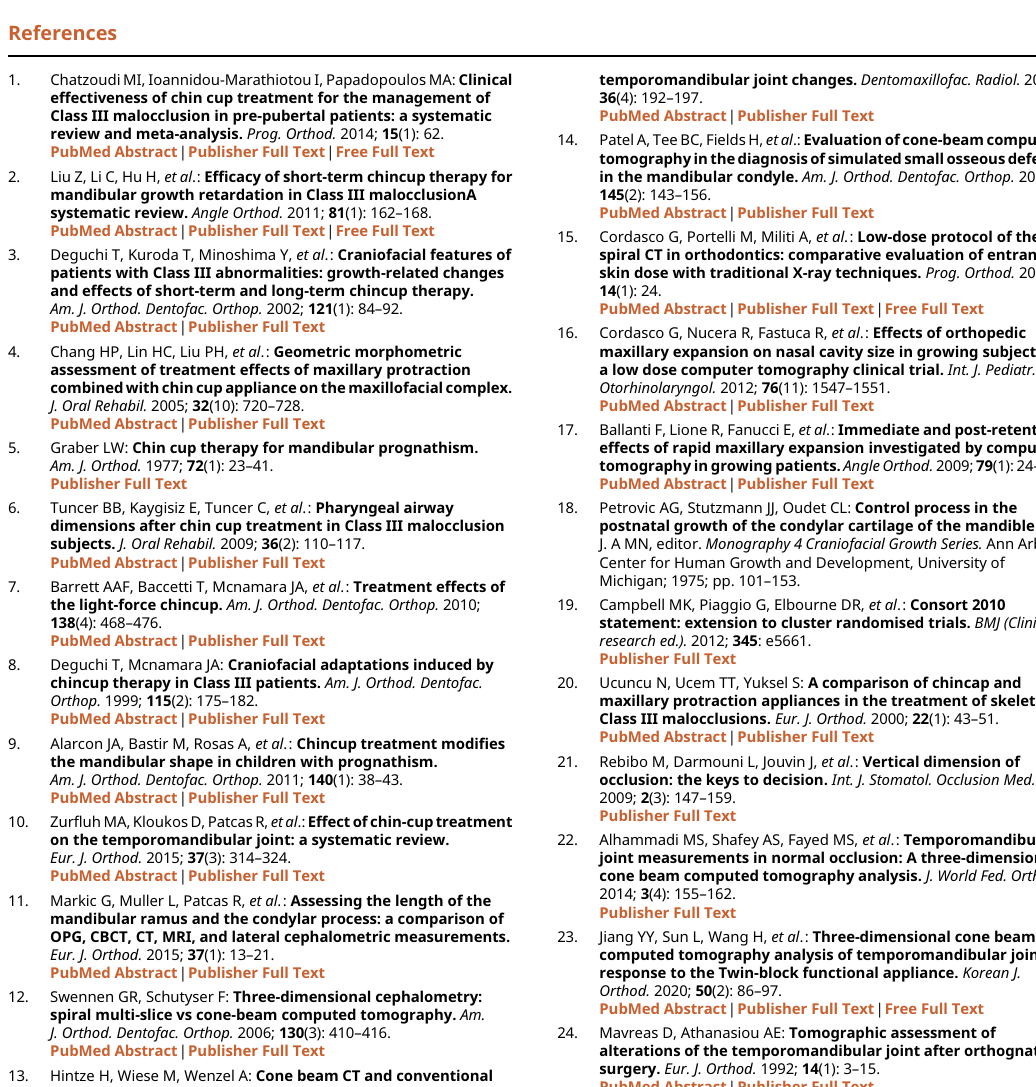
Figshare: CONSORT checklist for ‘ Evaluation of the Dimensional Changes in the Mandible, Condyles, and the Temporomandibular Joint Following Skeletal Class III Treatment with Chin Cup and Bonded Maxillary Bite Block Using Low-Dose Computed Tomography: A Single-center, Randomized Controlled Trial ’ . https://doi.org/10.6084/m9. figshare.21973517.v3.